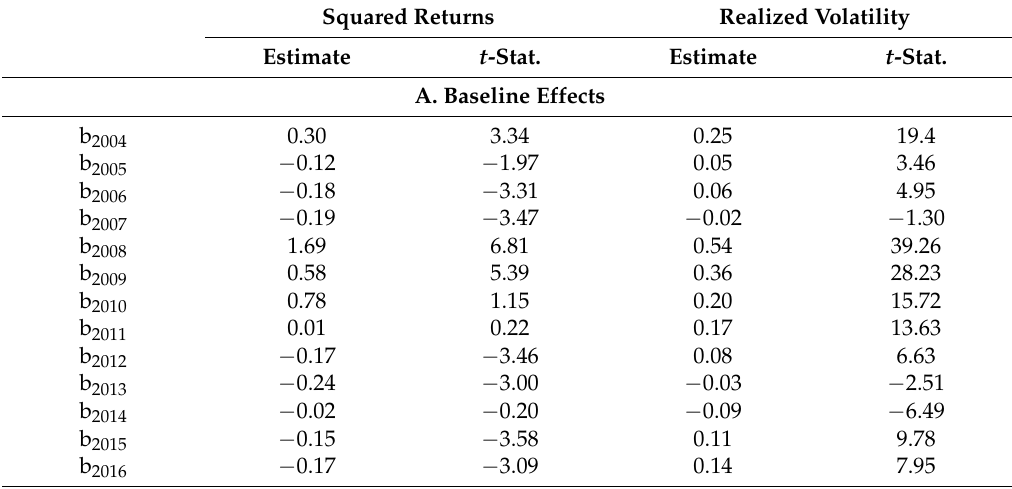
Table 5. Difference-In-Difference Analysis of Non-Energy